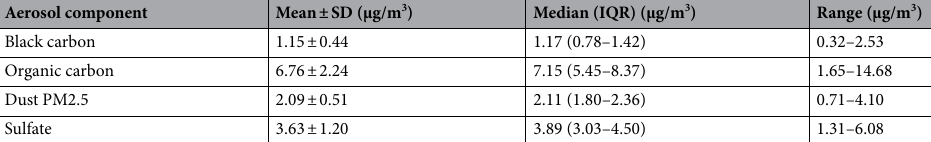
Table 2. Baseline accumulated aerosol component between 2014 and 2018. SD standard deviation; IQR interquartile range; PM2.5 particulate matter diameter < 2.5 µm.